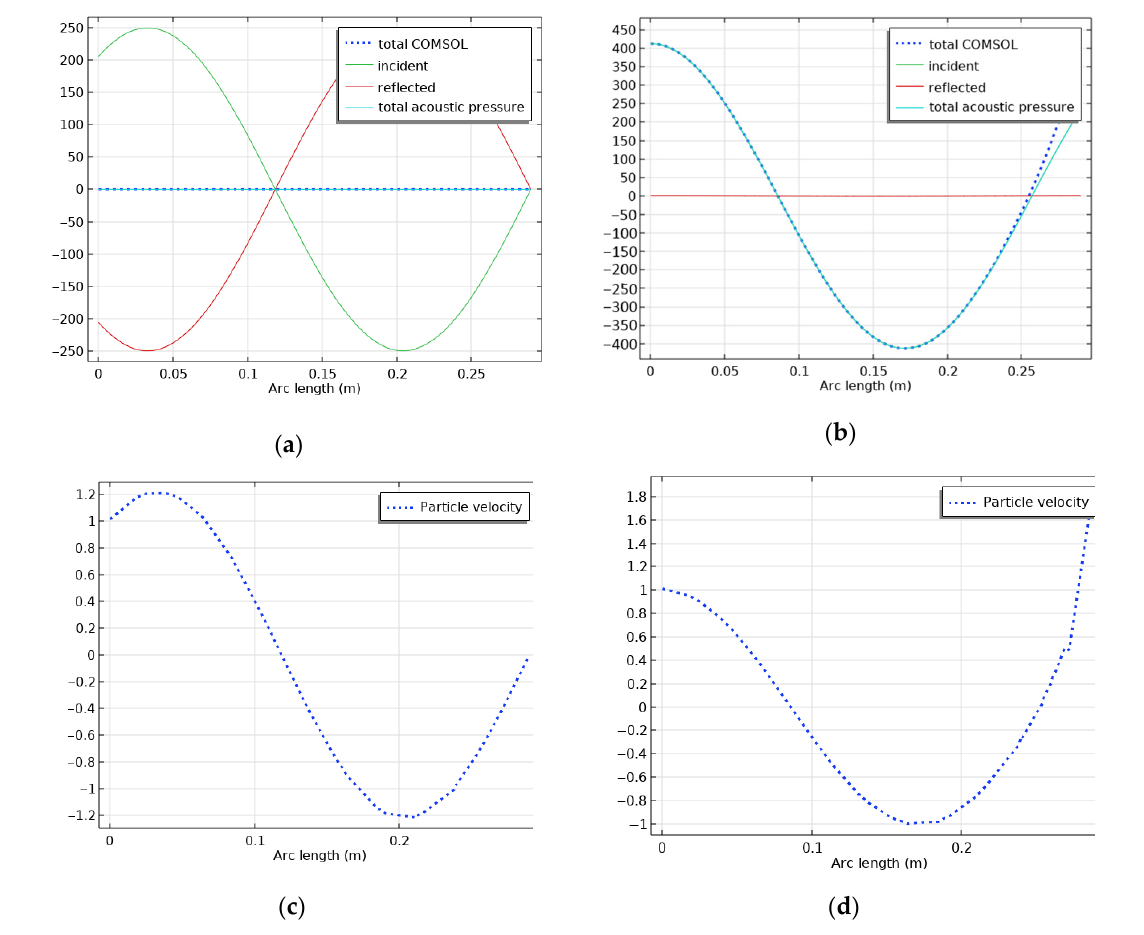
Figure 13. Simulation results of the 3D duct model in COMSOL: ( a ) real part of the pressure field in the passive case in Pascal and ( b ) real part of the pressure field in the active case in Pascal, ( c ) particle velocity of the pressure field at f = 860 Hz in the passive case in m/s and ( d ) particle velocity of the pressure field at f = 860 Hz in the active case in m/s. These results validate the control logic that maximises the absorption coefficients in the low-mid frequencies where the passive solutions are less effective.